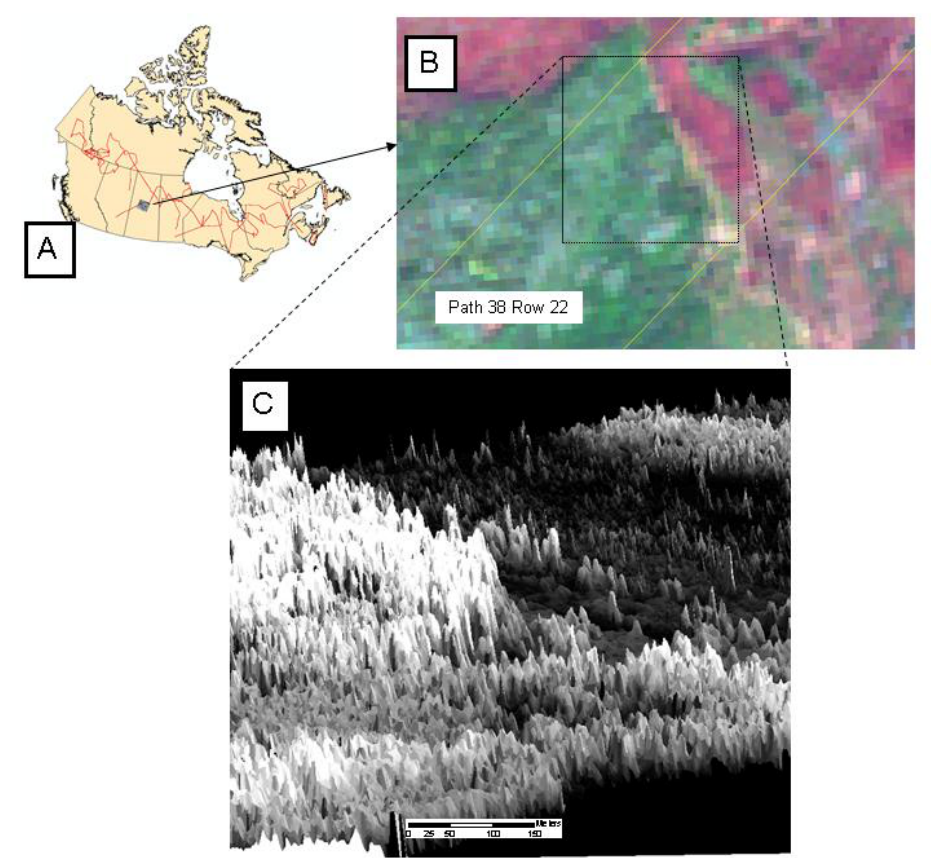
Figure 1. Context and example of a LIDAR transect at the boundary of a burned area. A. Overview of entire 2010 LIDAR campaign over the Canadian Boreal forest denoted in red. B. Sub-scene from Landsat-5 Path 38 Row 22 October 2003 RGB image of bands (5,4,3) with generalized LIDAR transect outline in yellow and the 2002 wildfire scar identified by the pixels with shades of pink. C. Three dimensional surface view of a 0.5 m LIDAR Canopy Height Model with the wildfire impact illustrated, boundary evident and unburned islands also evident. The sub-scene is located in Saskatchewan and is centered at 54°50′30″N,